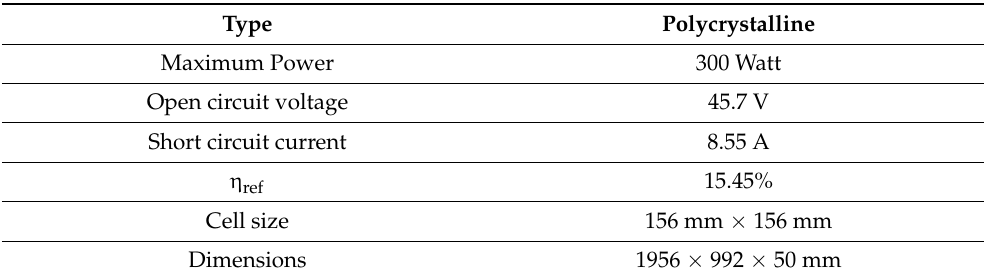
Table 6. PV panel